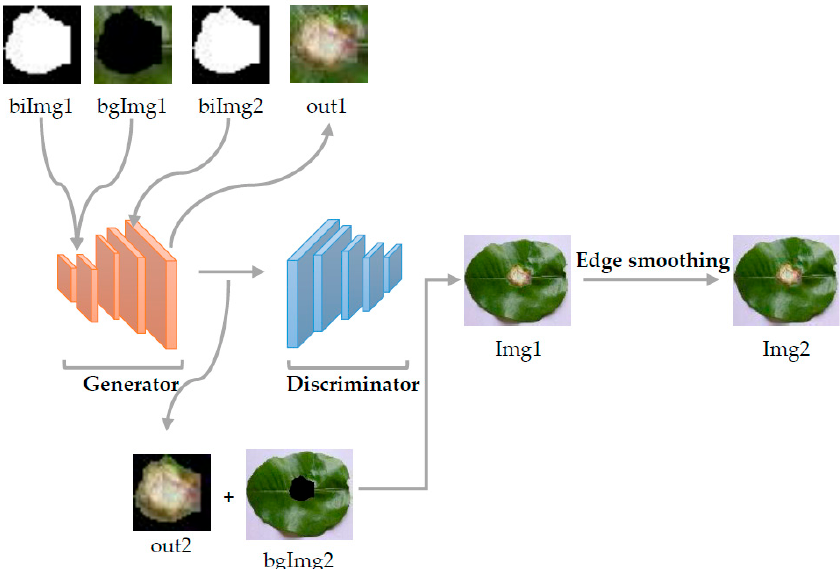
Figure 2. Architecture of our generator network. We had a total of five convolutional layers, where bgImg1 (8 × 8 × 3) and bgImg2 (256 × 256 × 3) were binarized marked leaf images, biImg1 (8 × 8 × 1) and biImg2 (64 × 64 × 1) were different sizes of the same binarized image. out1 (64 × 64 × 3) was the generated lesion image trained with the discriminator, and out2 (64 × 64 × 3) was the area of the lesion after binarization. Img1 was an image synthesized by out2 and bgImg2, and Img2 (256 × 256 × 3) was an image after the Img1 (256 × 256 × 3) edge smoothing.